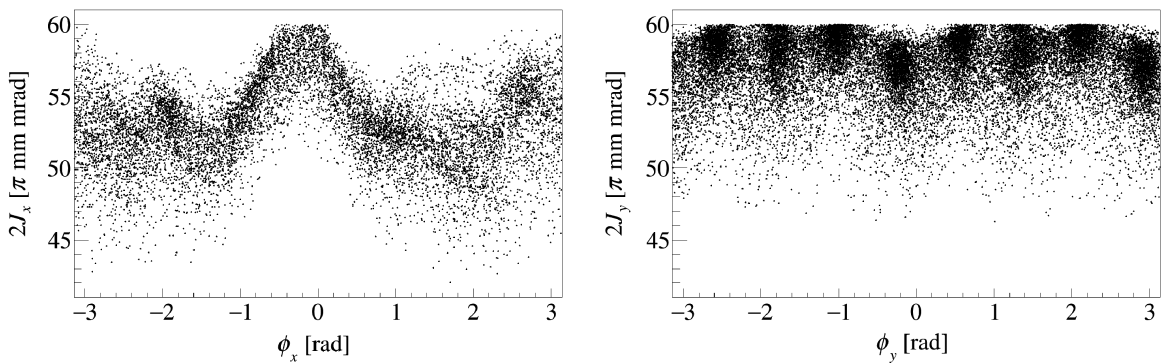
FIG. 3. Simulated phase space distributions of the lost particles with the present FX optics in action-angle coordinates. The left and right images show the phase space positions of the lost particles with J x > J y and J x < J y , respectively. The last 15 turn positions before the particles were lost are